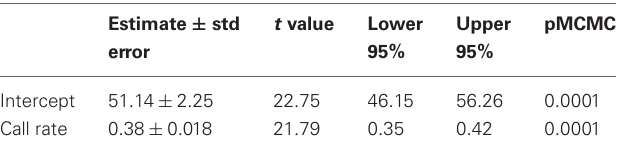
Table 1 | Model estimates of the relationship between rate of oxygen consumption (ml O 2 /h) and call rate (n/10s).